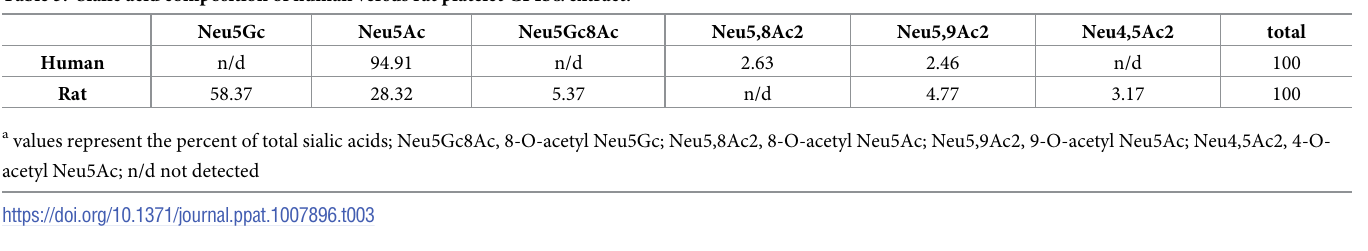
Table 3. Sialic acid composition of human versus rat platelet GPIb α extract. a